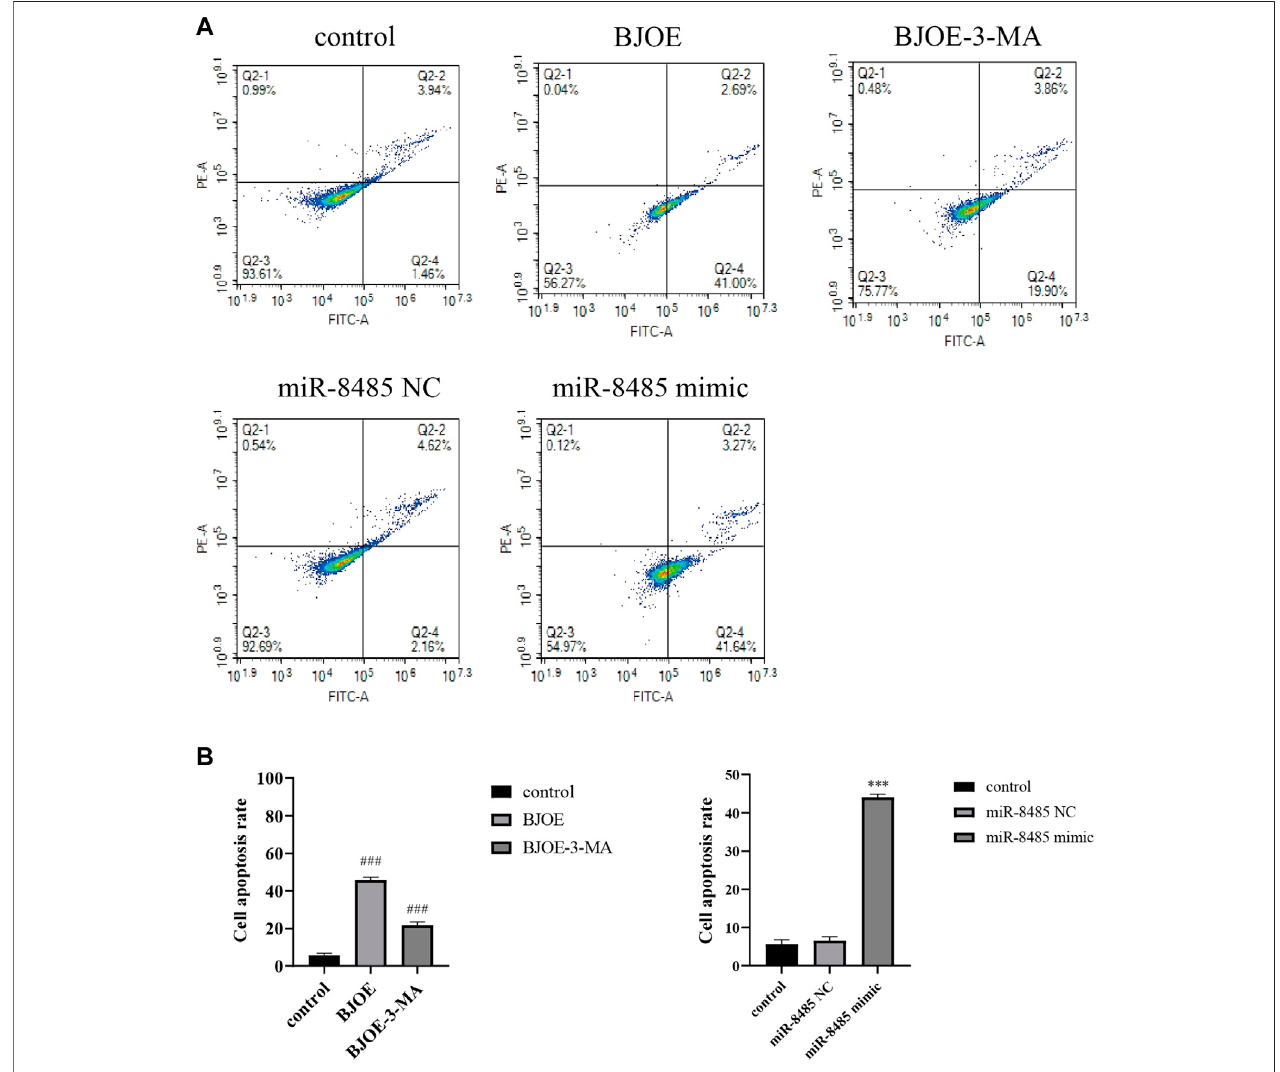
FIGURE 4 | Effects of Brucea javanica oil emulsion and overexpression of miR-8485 on apoptosis of SKOV3 cell. (All the p values were compared with the control group (n = 3). Results are represented as mean ± SD. ### p < 0.001, *** p < 0.001).